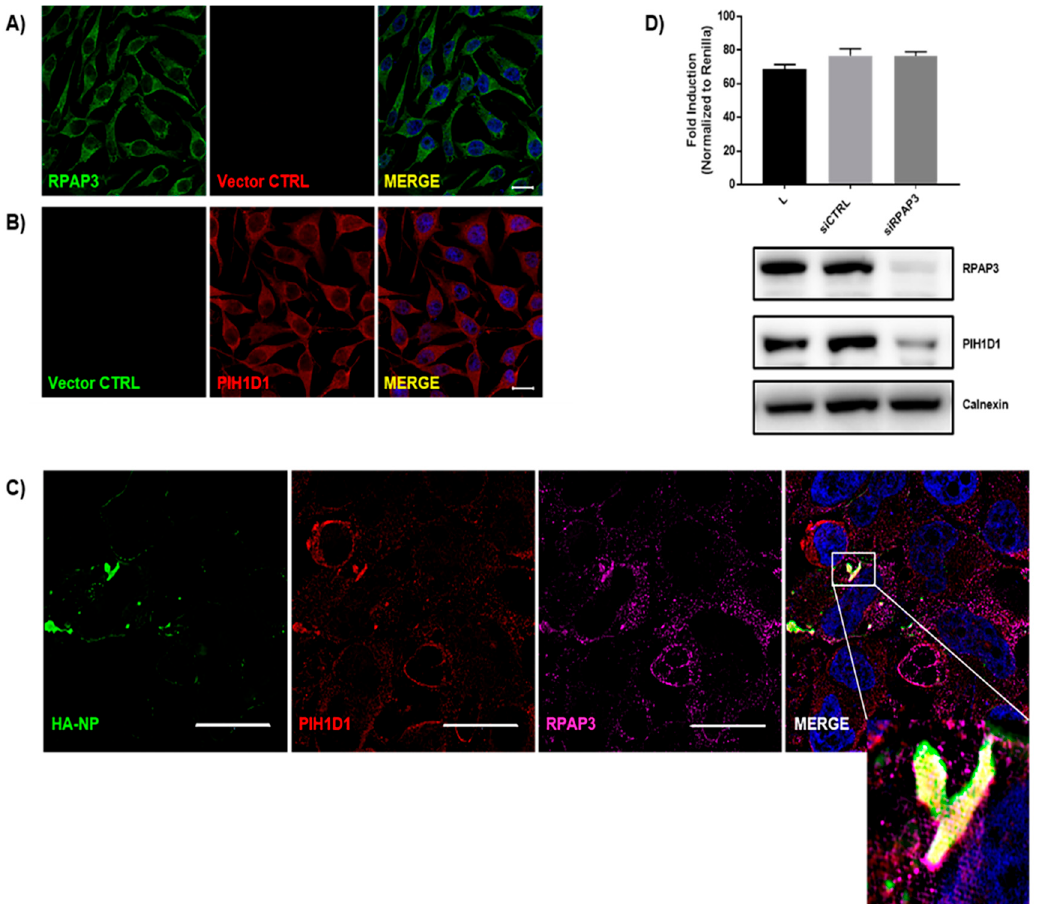
Figure 5. The R2TP complex components RPAP3 and PIH1D1 colocalize with HA-NP. HeLa cells were transfected with vector control or HA-NP. Twenty-four hours later, the cells were fixed and processed for the immunofluorescence detection of endogenous PIH1D1 or RPAP3 in the presence of vector control or HA-NP. Representative images of endogenous localization pattern of ( A ) RPAP3 with vector control and ( B ) PIH1D1 with vector control. RPAP3 or vector control (green), PIH1D1 or vector control (red), and Hoechst 33342 nuclear stain (blue) were visualized by confocal microscopy. Scale bars = 20 µ M. ( C ) Representative images of endogenous localization pattern of PIH1D1 and RPAP3 in the presence of HA-NP. HA-NP (green), RPAP3 (red), PIH1D1 (magenta), and Hoechst 33342 nuclear stain (blue) were visualized by SIM. Scale bars = 20 µ M. ( D ) Minigenome activity upon the knockdown of RPAP. Below are protein levels confirmed by immunoblot. HeLa cells were transfected with 30 nM scrambled siRNA or 30 nM siRNA targeting RPAP3. Twenty-four hours after siRNA addition, the minigenome components were transfected. Forty-eight hours later, minigenome reporter activity was measured. Data represent mean ± SEM from one representative experiment ( n = 3) of at least three experiments. 4. Discussion.